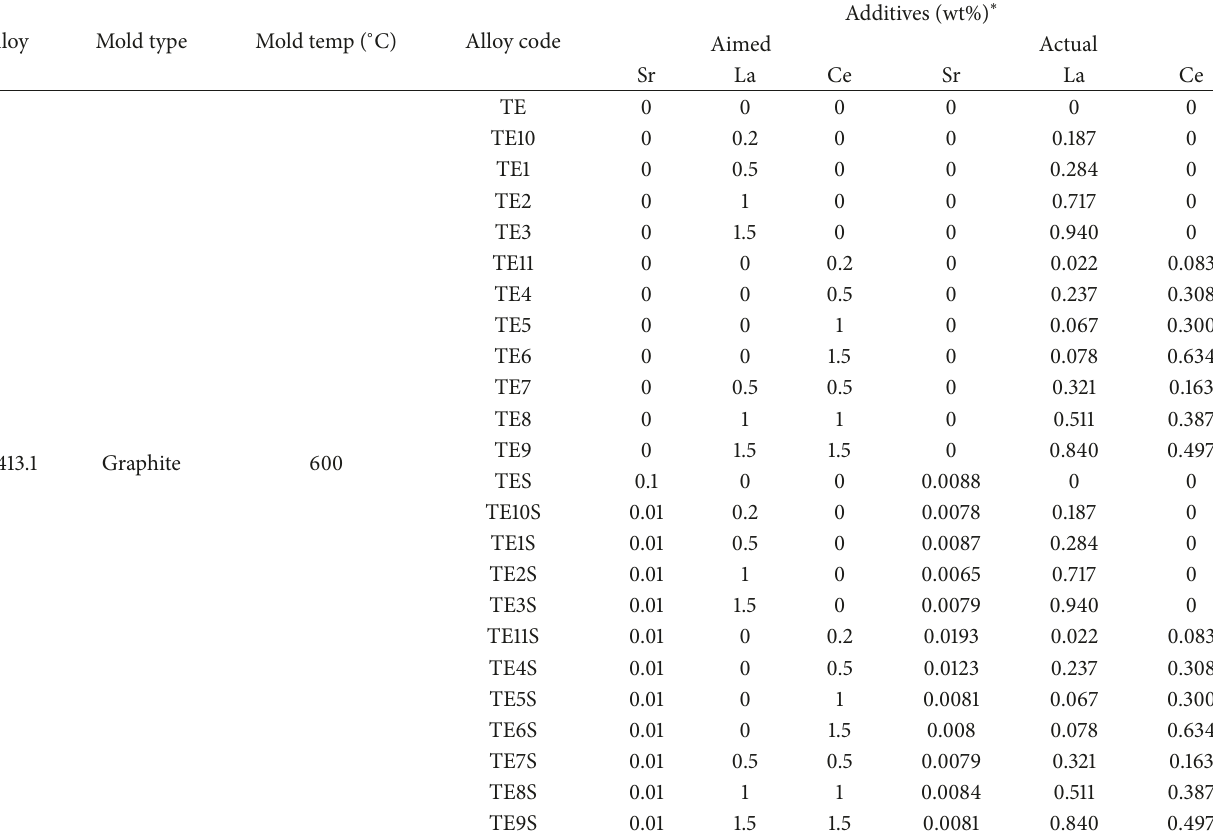
Table 2: Chemical composition and codes of the A413.1 alloys used in the present study, graphite mold castings. Alloy